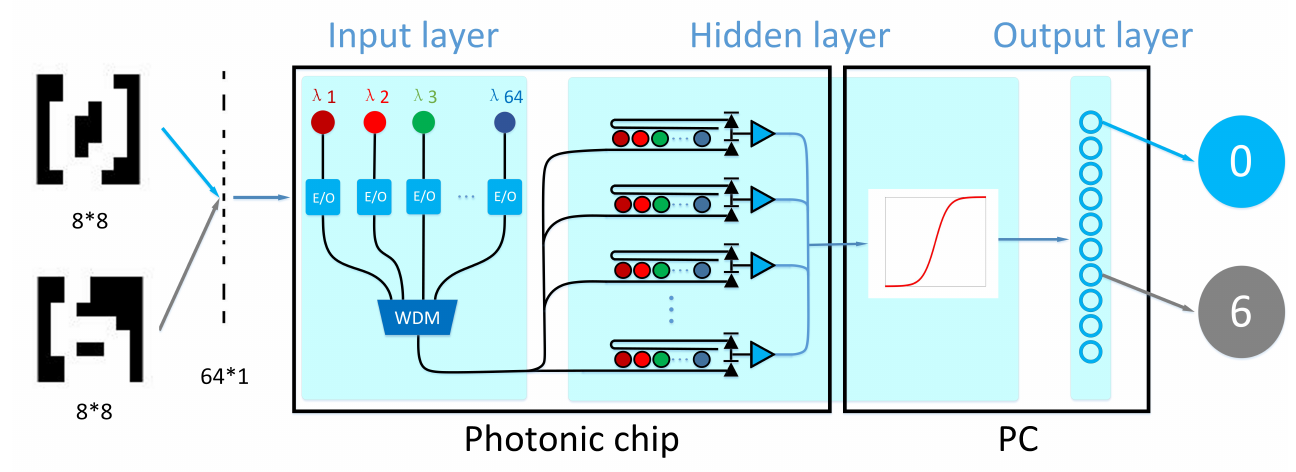
Figure 4. Diagram of the three-ply optical neural network solving MNIST. The two-dimensional images of 8 × 8 are converted into a one-dimensional image of 64 × 1, and they are put into the photoelectric modulators and modulated with 64 optical carrier